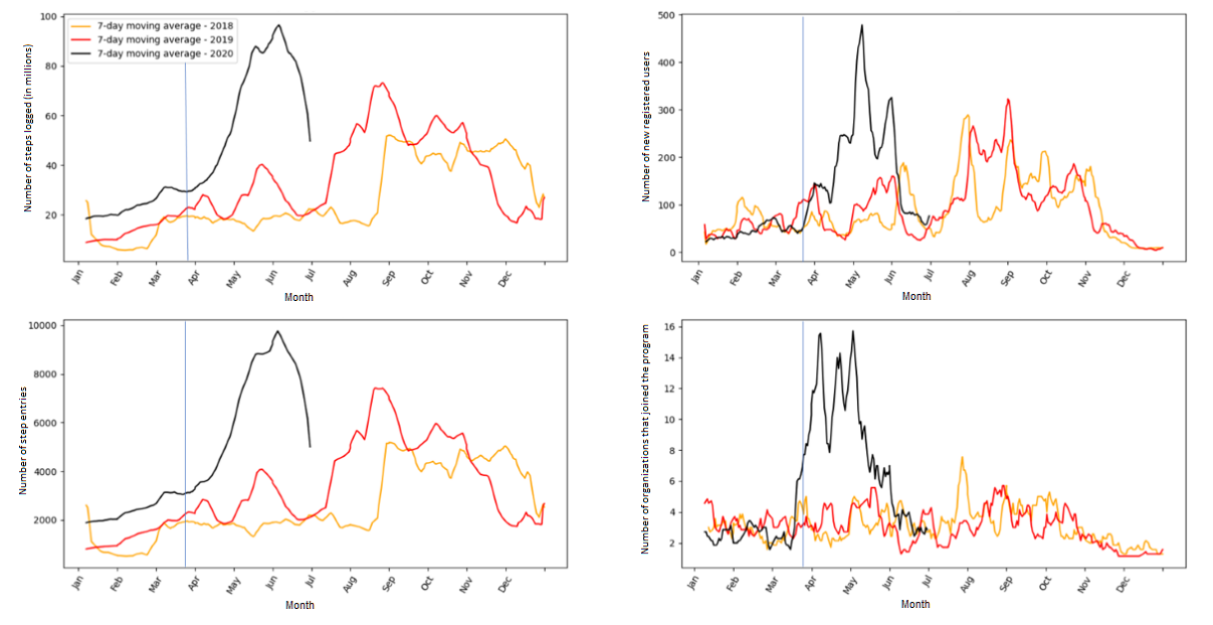
Figure 3. The total number of steps logged, step entries, and new registered users and organizations over time. The vertical line in each graph indicates the start of the